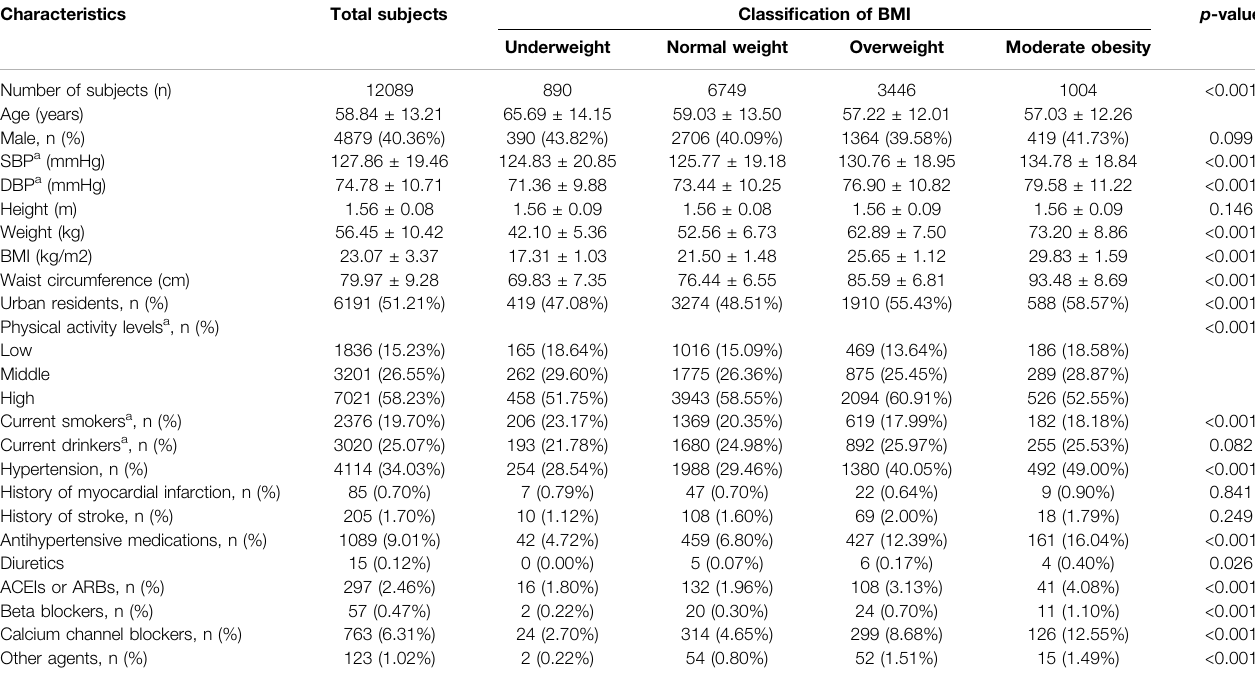
TABLE 1 | Baseline characteristics of the study population according to different BMI categories. Characteristics